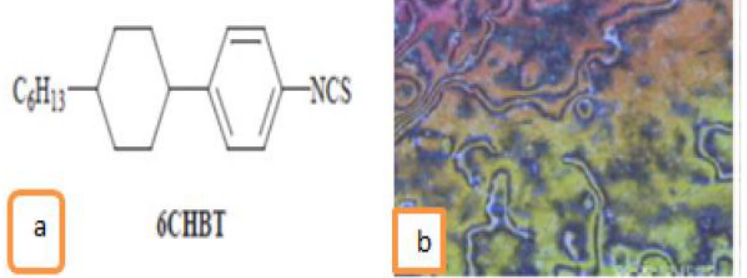
Fig.2: a Chemical structure of 6CHBT LC, b: 6CHBT LC image under the microscope [16]. 6CHBT had been doped (in the isotropic phase under continuous stirring) with different NP’s. A magnetic suspension consisting of rod-like Fe Oleic acid as a surfactant was used. The average diameter of rod-like NP’s was 16 nm and the mean length determined from the histogram of the size distribution was 70 nm. The morphology and size distribution of the doped NP’s were studied by transmission electron microscopy (TEM) (Tesla BS 500) as shown in